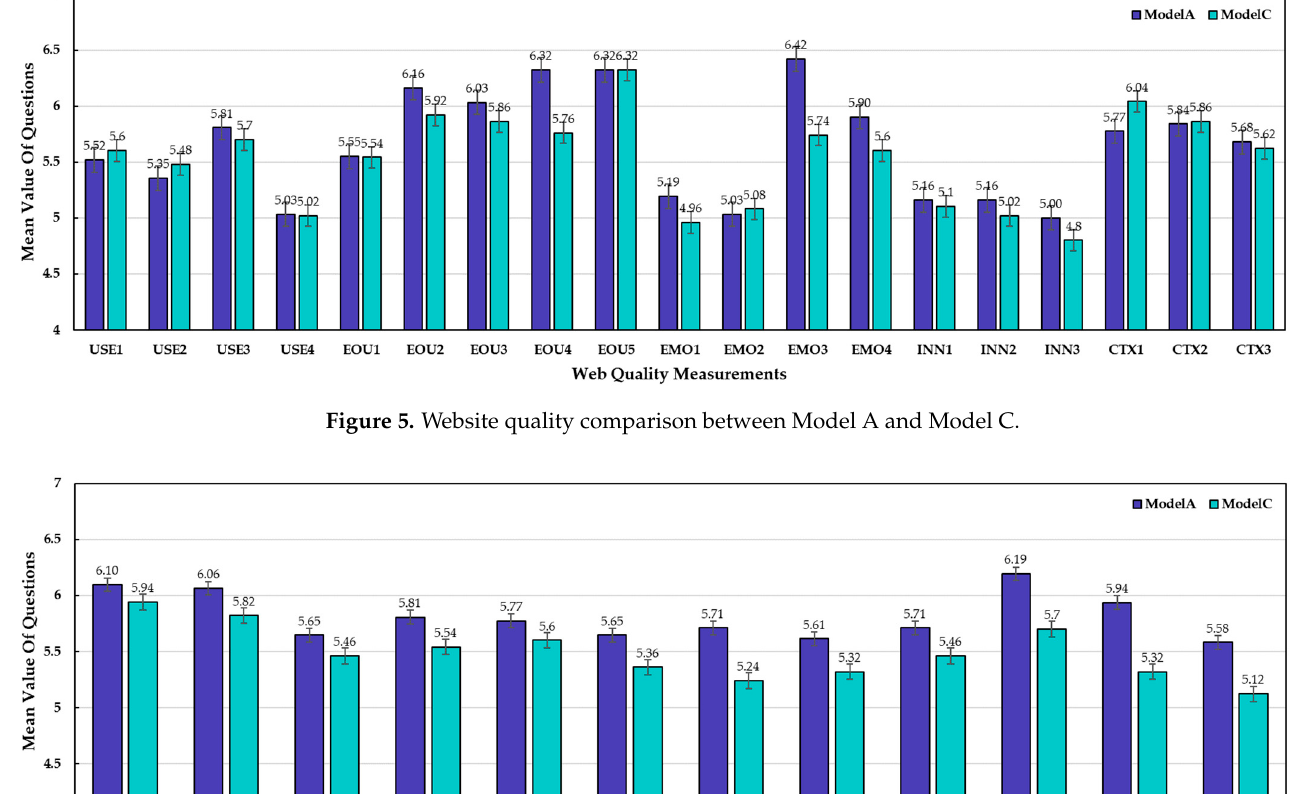
Figure 7. Website quality comparison between Model B and Model C. Figure 8. Comparison of user attitudes and user intentions between Model B and Model C.